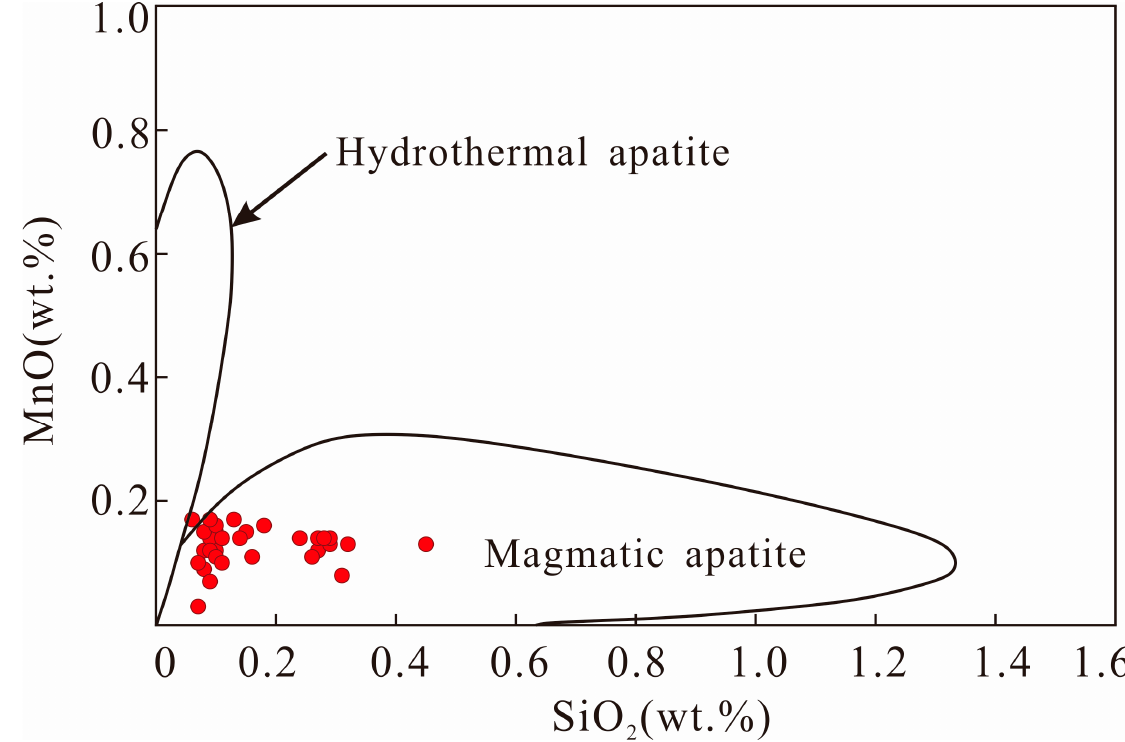
3 Figure 4. Plots of MnO versus SiO 2 in apatites of dacite ( modified from ref.